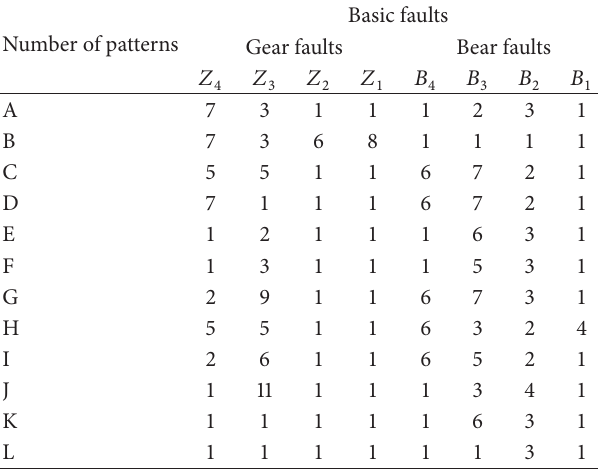
Table 5: Condition patterns of the experiment. Number of patterns